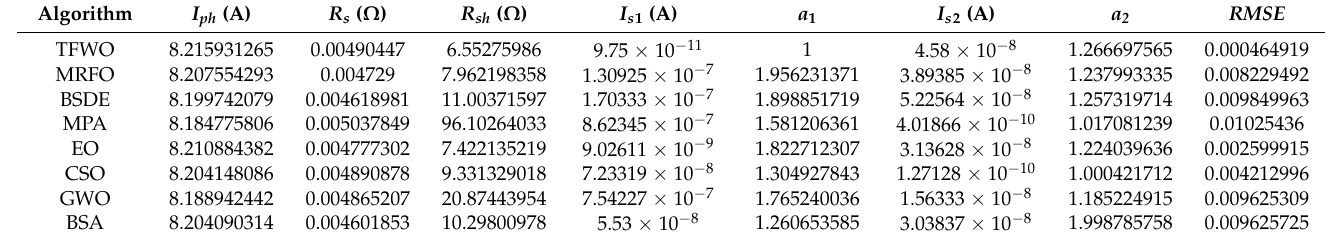
Table 10. Extracted parameters for KC200GT DDM.